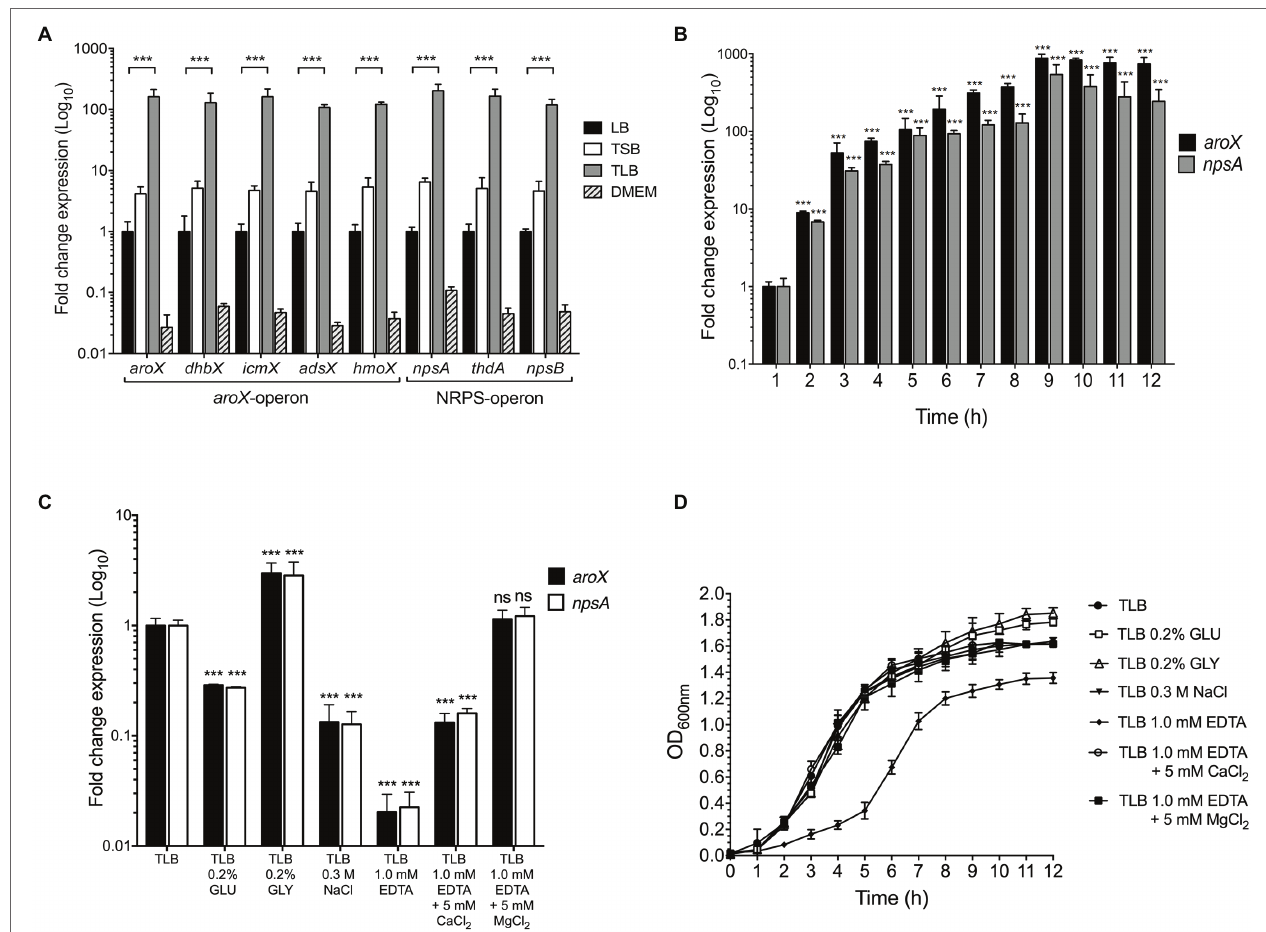
FIGURE 1 | Effect of environmental cues on aroX and NRPS operons expression. (A) Fold change expression detected by RT-qPCR of aroX and NRPS operons of K. oxytoca compared to LB. Bacterial cultures were grown at 37 ° C for 9 h in different culture media: lysogenic broth (LB), tryptone soy broth (TSB), tryptone lactose broth (TLB), and Dulbecco’s modified Eagle’s medium (DMEM) with high glucose (4.5 g/l). (B) Transcription of aroX and npsA genes during growth phases. (C) Transcription of aroX and npsA genes at stationary phase (OD 600nm = 1.6) at 37 ° C under different environmental conditions determined by RT-qPCR. (D) Growth curves of wild-type K. oxytoca in TLB medium at 37 ° C for 12 h supplemented with glucose (GLU, 0.2%), glycerol (GLY, 0.2%), sodium chloride (NaCl, 0.3 M), and ethylenediaminetetraacetic acid (EDTA, 1.0 mM, supplemented or not supplemented with 5.0 mM CaCl 2 /MgCl 2 ). 16S rRNA was used as a reference gene for normalization of expression. These graphs represent the mean of three independent experiments performed in triplicate with standard deviations. Statistically significant with respect to bacteria grown in LB medium (A) or with respect to bacteria grown after 1 h post-inoculation in TLB medium (B) or with respect to bacteria grown in non-supplemented TLB medium (C): ** p < 0.001. All values of p were calculated using one-way ANOVA and Tukey’s comparison